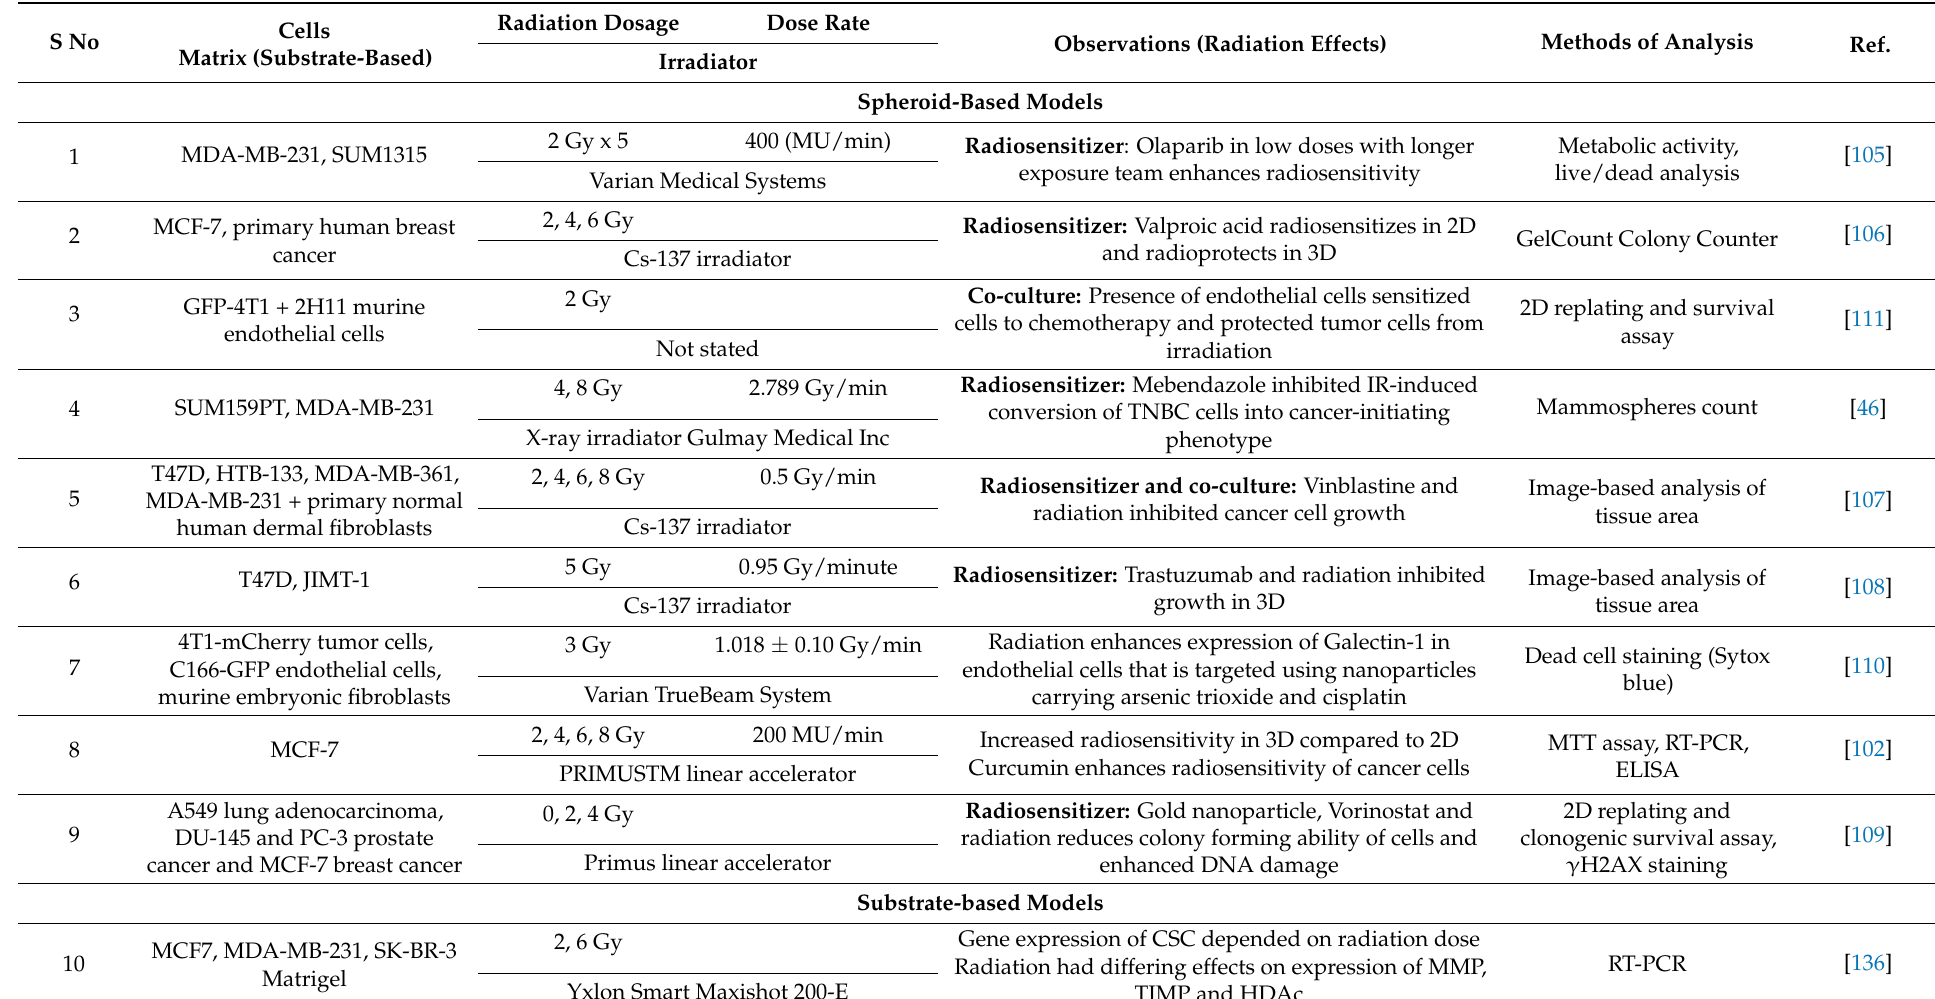
Table 1. In vitro radiobiology studies conducted using 3D models (spheroid-based and substrate-based) of breast cancer